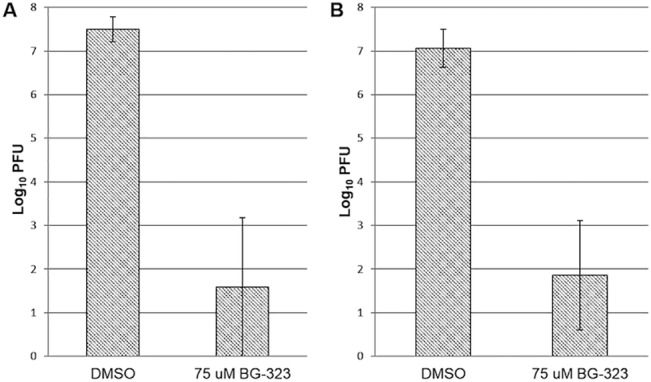
Effects of BG-323 administration on virulent Powassan and West Nile viruses in cell culture.(A) BHK21 cells were infected with 100 PFU Powassan virus (strain LB) and administered either DMSO vehicle or 75 μM BG-323. After 72 hours, media was collected and viral loads were titered using a standard plaque assay (n = 3). (B) BHK21 cells were infected with 100 PFU WNV (NY99) and either DMSO vehicle or 75 μM BG-323. After 72 hours, media was collected and viral loads were titered using a standard plaque assay (n = 3). 75 μM BG-323 caused an approximate 5-fold reduction in viral titers compared to DMSO controls in both WNV and Powassan virus-infected cell cultures. BG-323 treated samples were significantly different than DMSO treated samples by two-tailed student t-test for both viruses with p-values of 0.02 and 0.01, respectively.